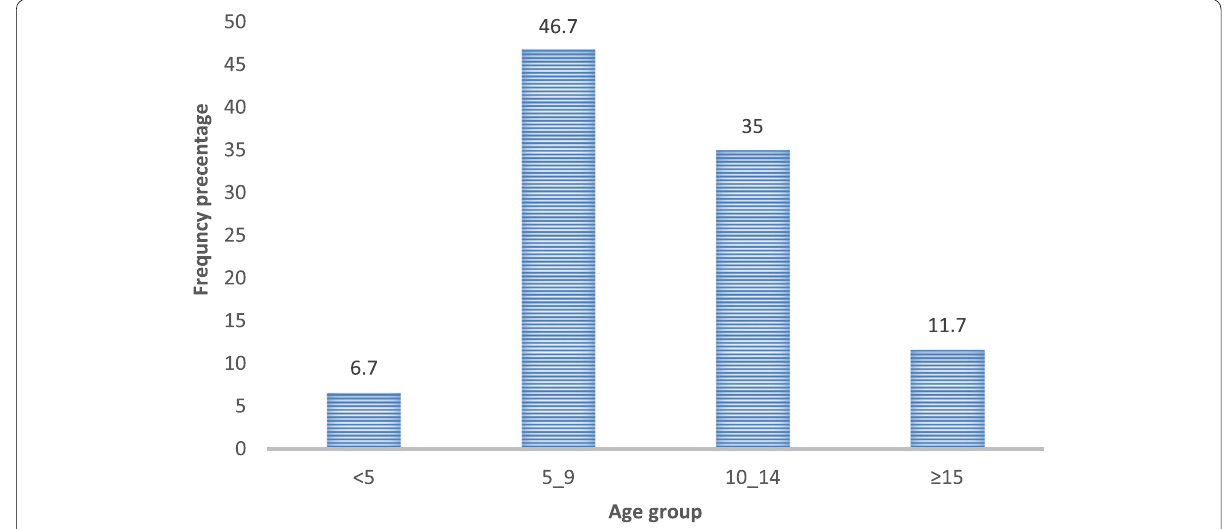
Fig. 1 Frequency percentage of the age group of patients under study